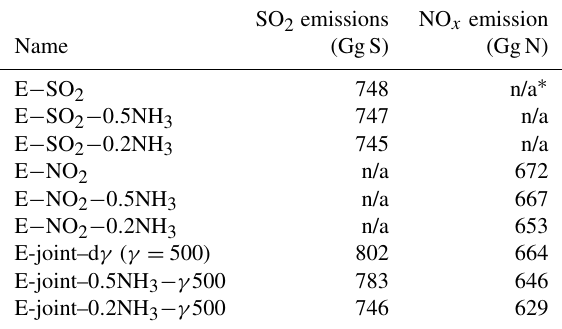
Table 4. Posterior anthropogenic emissions for October 2013 under different NH 3 emission